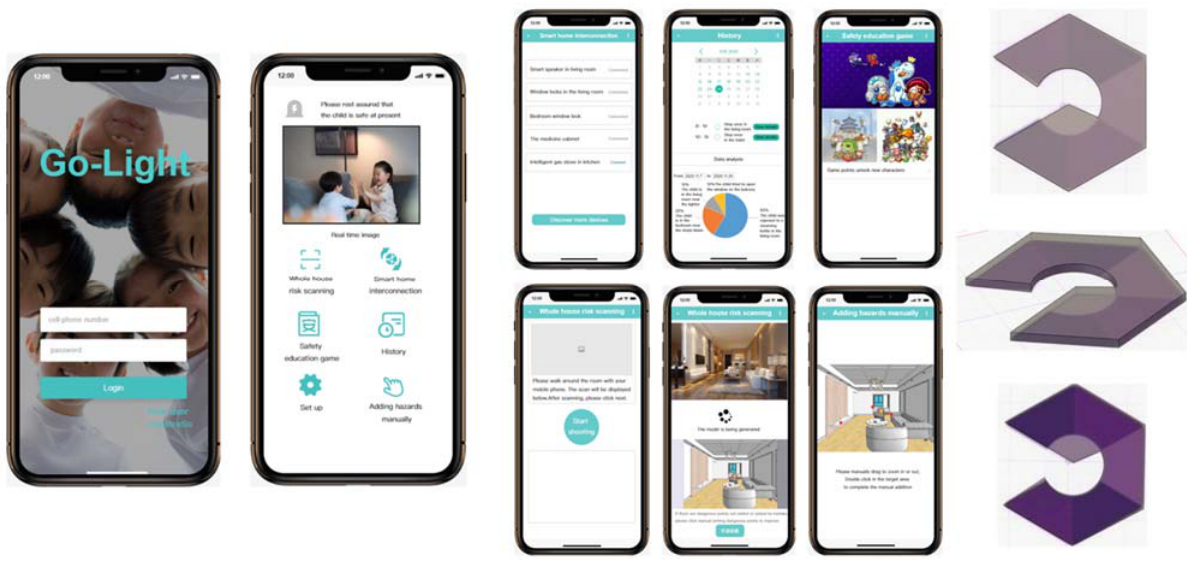
Figure 6. The user interface prototypes of the mobile app. Different shapes and personalities are given for the elf according to different home contexts.